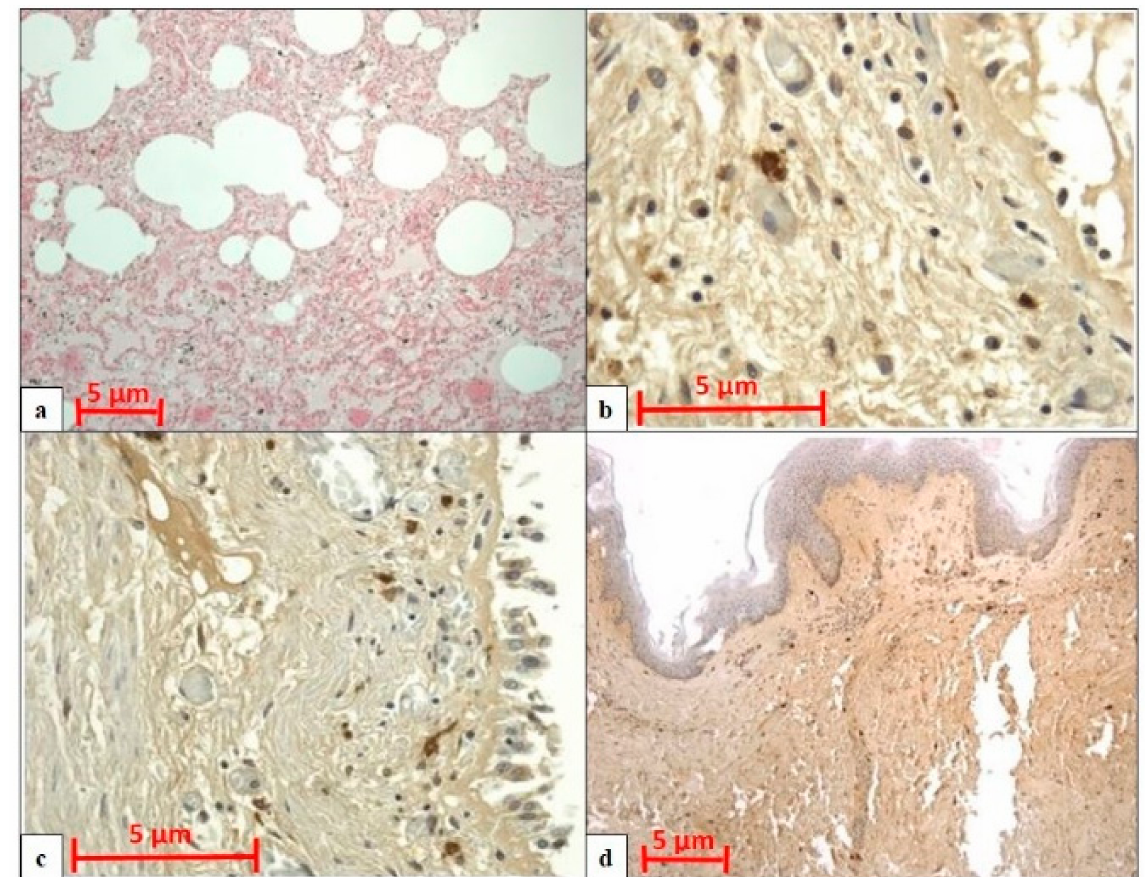
Figure 3. ( a ) H&E examination of lung samples shows capillary congestion and severe alveolar edema (amplification: 20 × ; scale bar: 5 µ m). ( b ) IHC examination of lung samples with strong anti-tryptase immunopositivity (magnification: 40 × ; scale bar: 5 µ m). ( c ) IHC examination of pharyngeal samples with strong anti-tryptase immunopositivity (magnification: 40 × ; scale bar: 5 µ m). ( d ) IHC examination of skin samples with strong anti-tryptase immunopositivity (magnification: 20 × ; scale bar: 5 µ